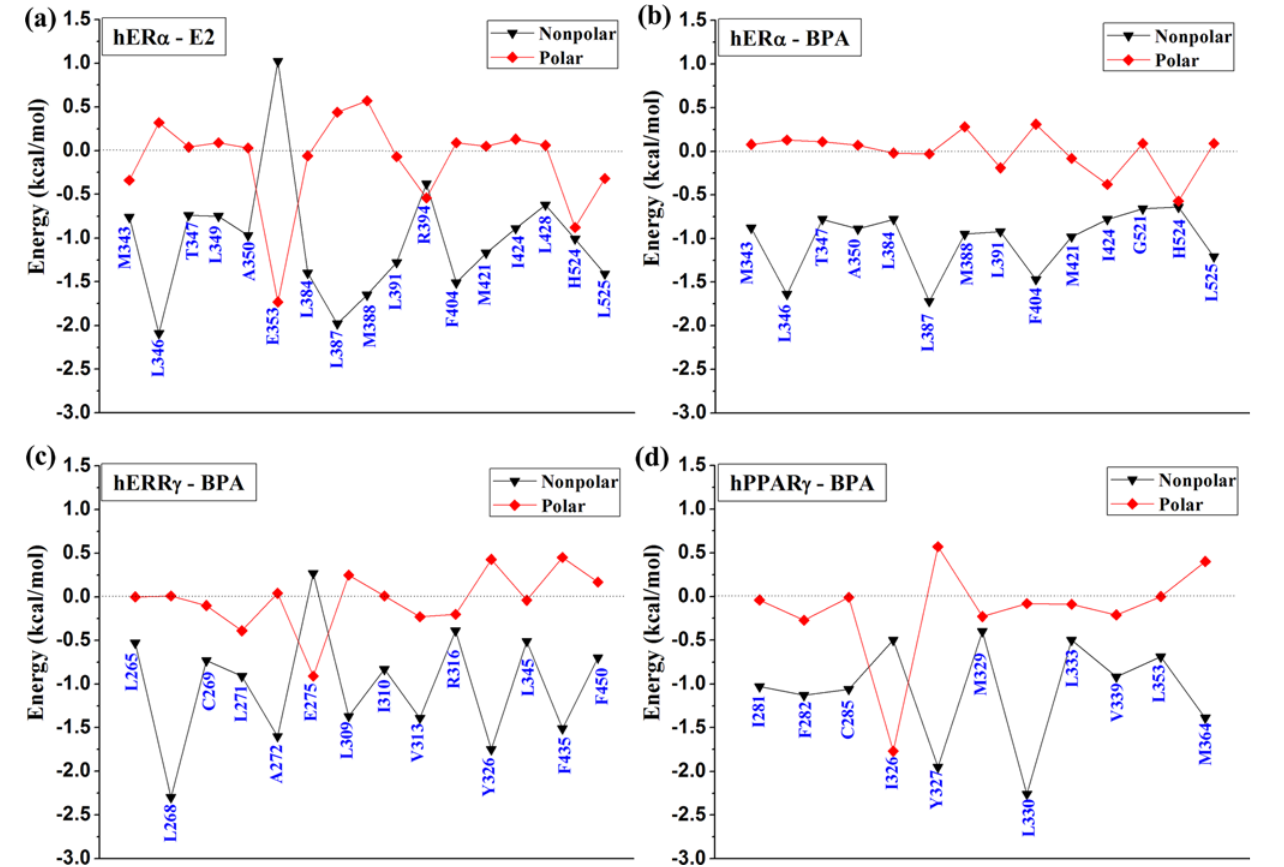
Fig 9. Polar and nonpolar energy contributions of the identified key residues to the complex